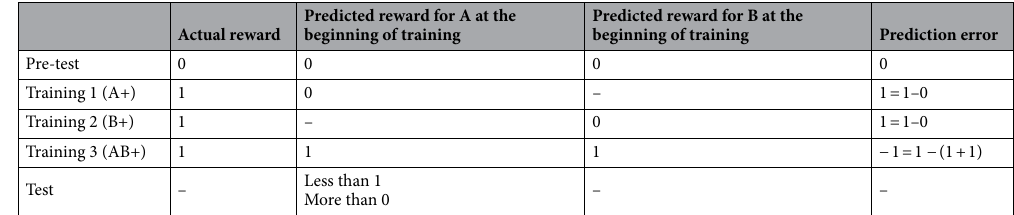
Predicted reward for B at the beginning of training